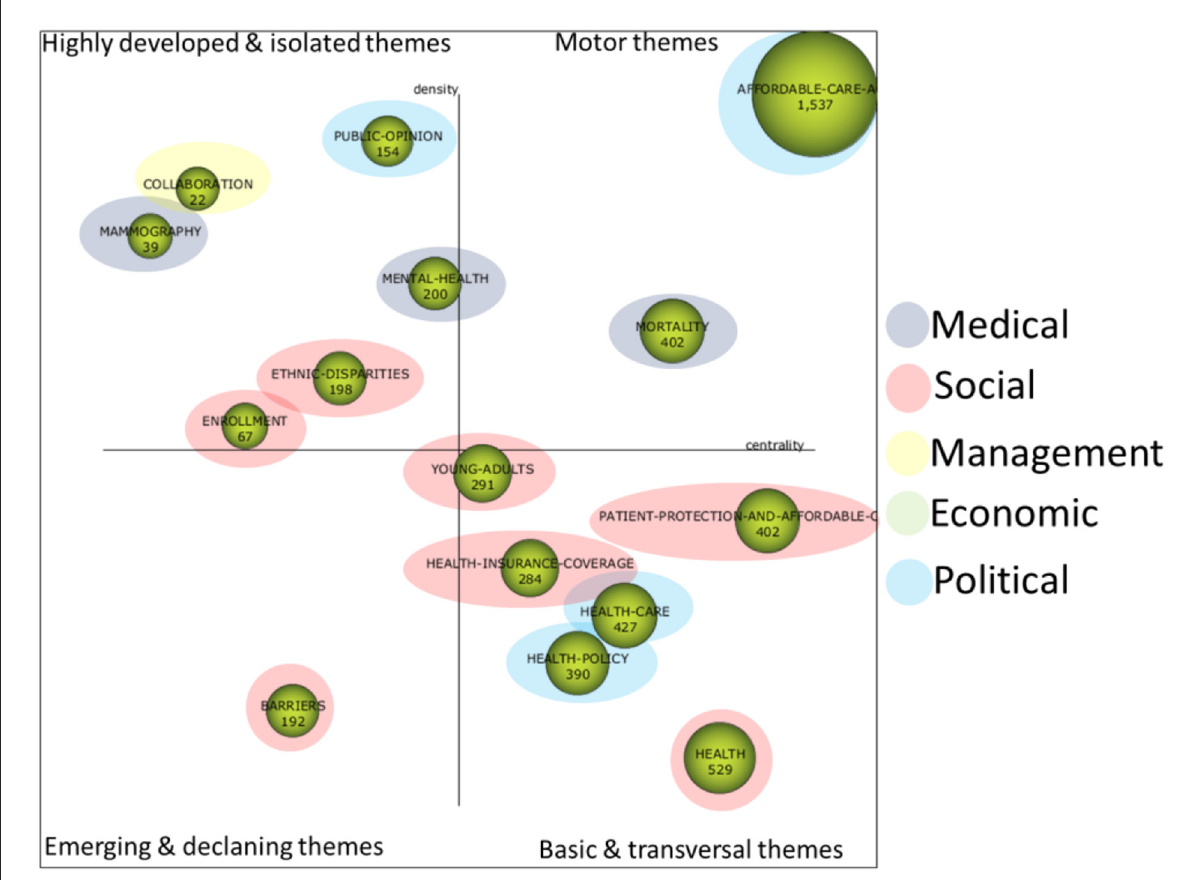
FIGURE5 Strategic diagram analysis period